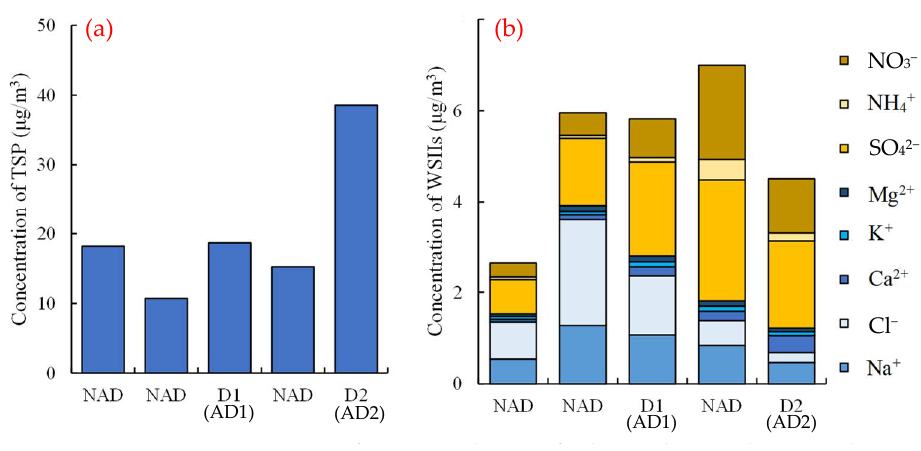
Figure 3. Concentration variations of TSP ( a ) and WSIIs ( b ) during the sampling period. D1 and. D2 are the sampling periods that contains the AD1 and AD2 events, respectively.